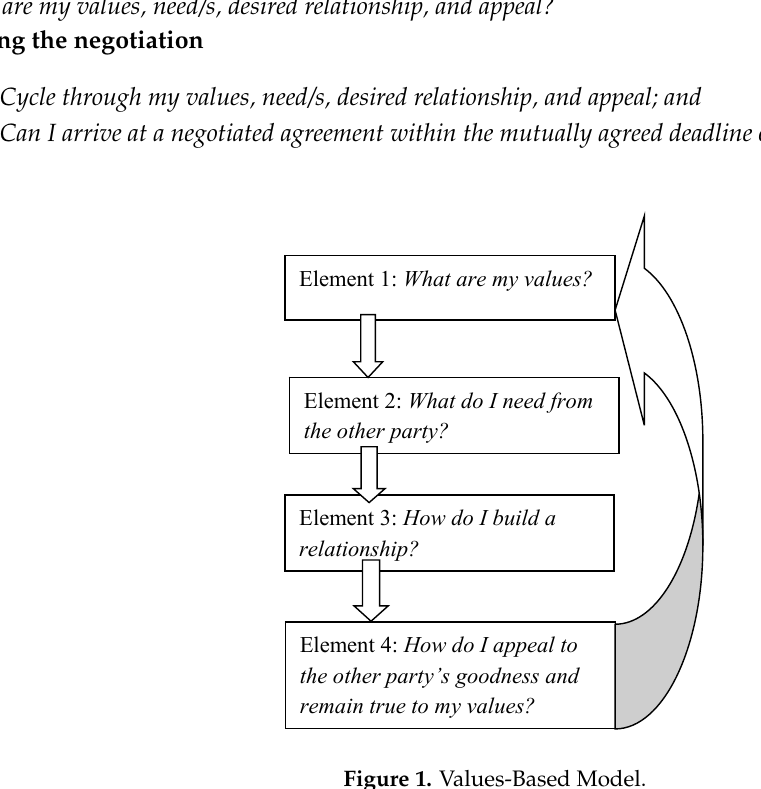
Figure 1. Values-Based Model.